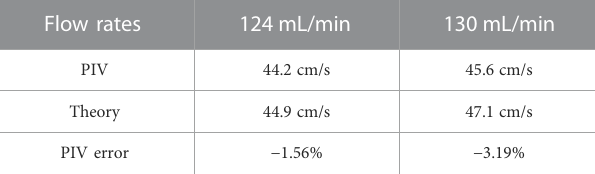
TABLE 2 Maximum velocities of PIV and theoretical values and the error for both fl ow